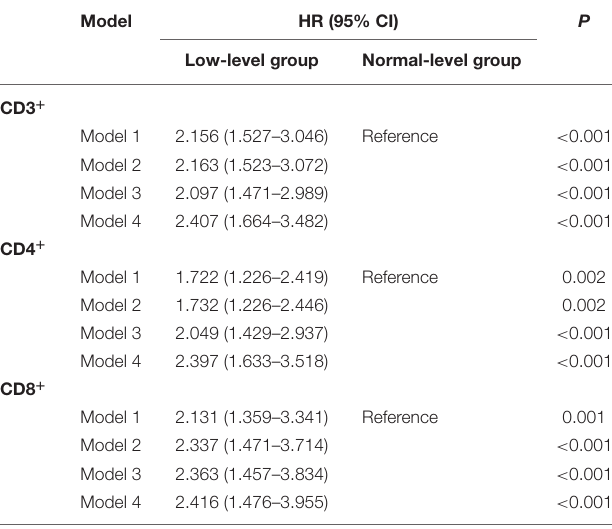
TABLE 4 | Association of CD3 + , CD4 + , and CD8 + T cells with renal